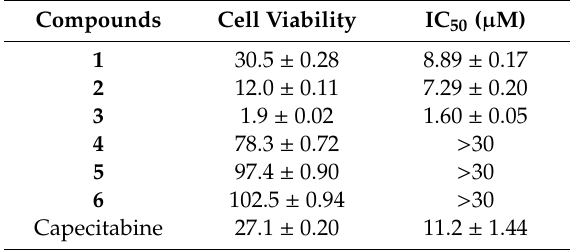
Table 2. Cytotoxic effects of compounds 1 – 6 on human cancer cell line, PC-3. Compounds